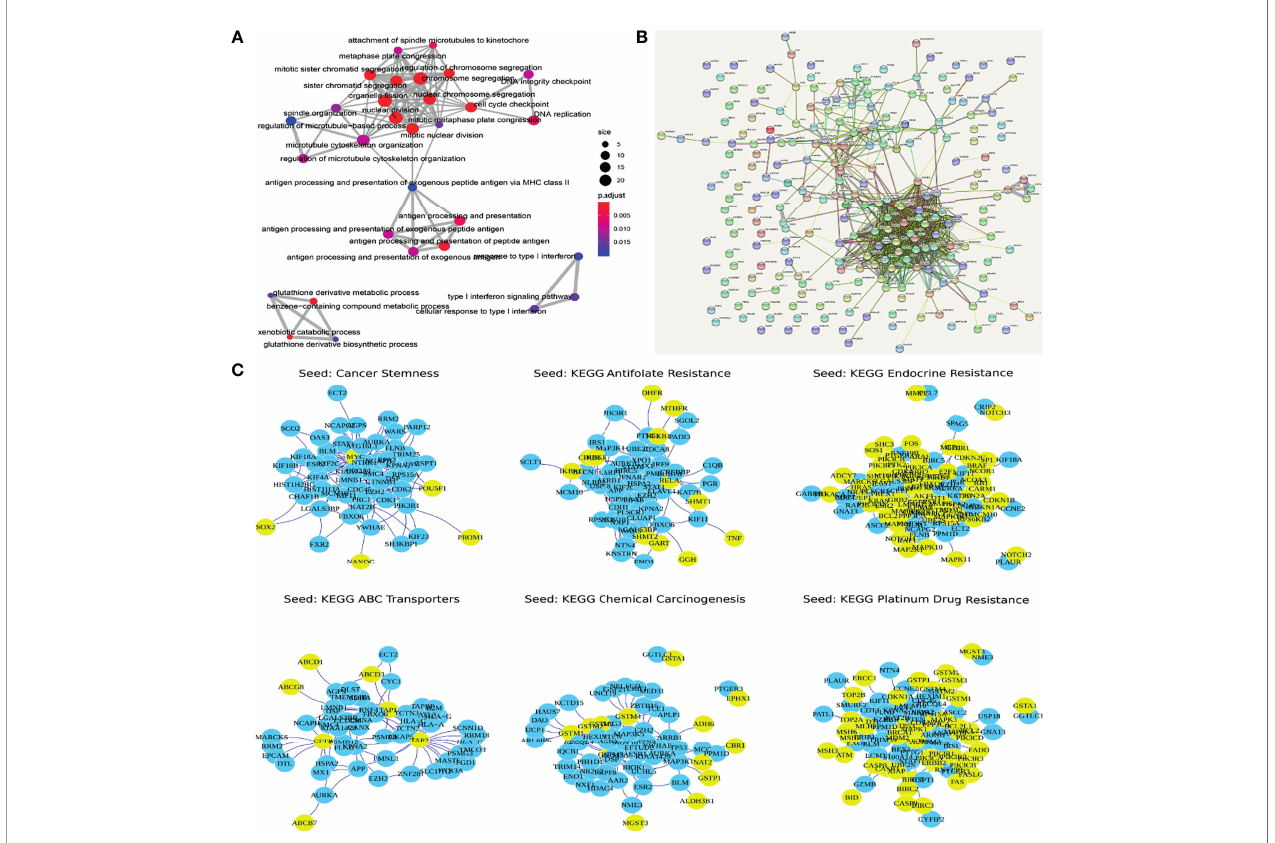
FIGURE 2 | (A) Functional enrichment of genes with potential functions in drug response. (B) Protein interactive networks of differentially expressed genes. (C) Top 50 genes using random walk algorithm (yellow nodes are seed